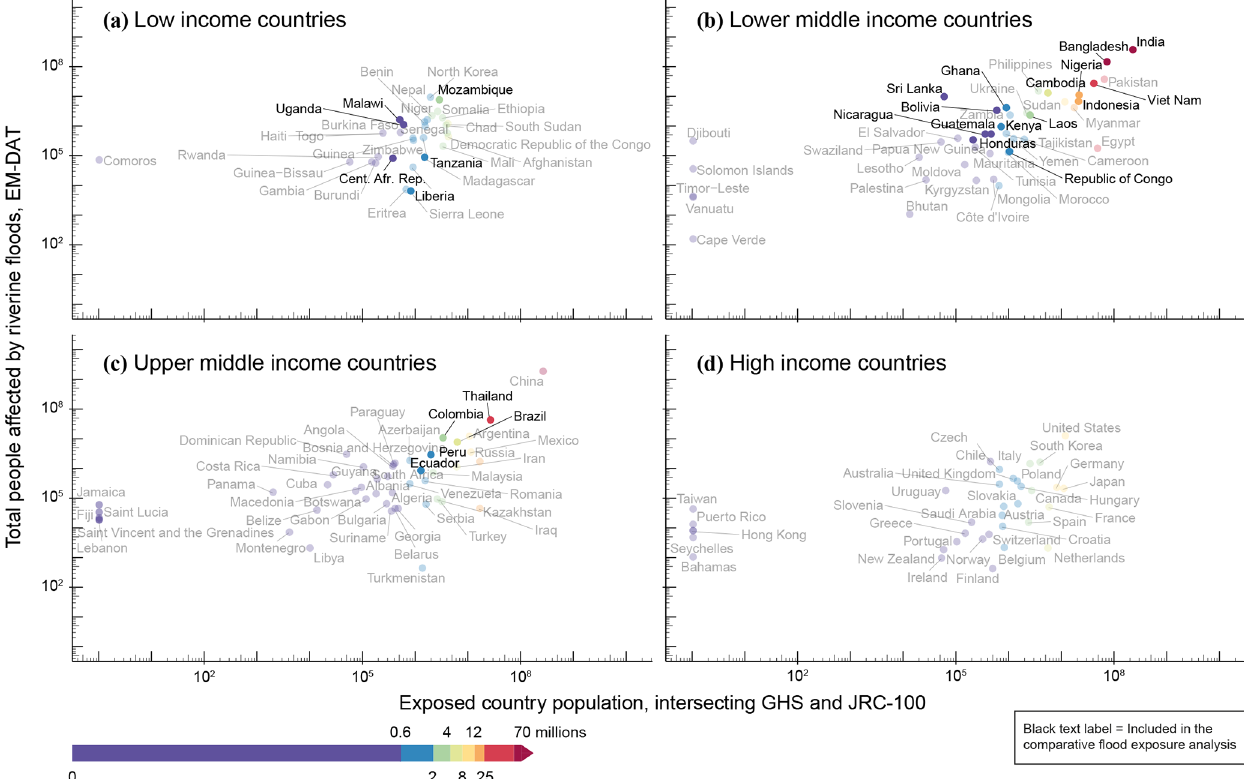
Figure 1. Flood exposure in the 26 countries for which we conducted the comparative riverine flood exposure analysis, here marked with black text labels. Flood risk is represented here as the combination of the country population within the 100-year flood hazard map (inter- secting the Global Human Settlement population grid count for 2015 with the JRC flood hazard map) and actual disaster reports of people affected by riverine floods between 1900 and 2020 as included in the Emergency Events Database EM-DAT. Please note that the axes have logarithmic scales. The country income classification is based on GNI per capita for the year 2015, given by the World